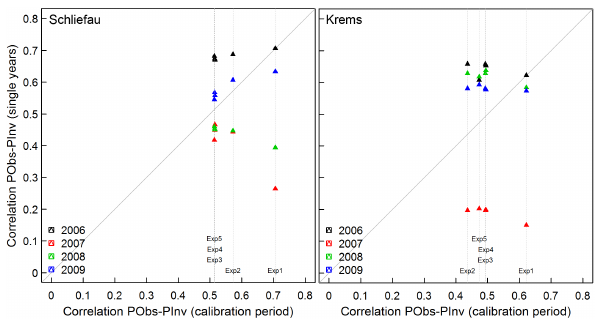
Figure 10. Correlation between P obs and P inv for the calibration pe- riods of the simulation experiments Exp 1 –Exp 5 versus single years for the two study areas.